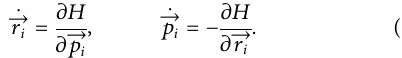
FIGURE 2 Time evolution of R 0 - P 0 contour plots of (anti-)deuteron from the central Au + Au collisions at range of experimental data from the STAR collaboration